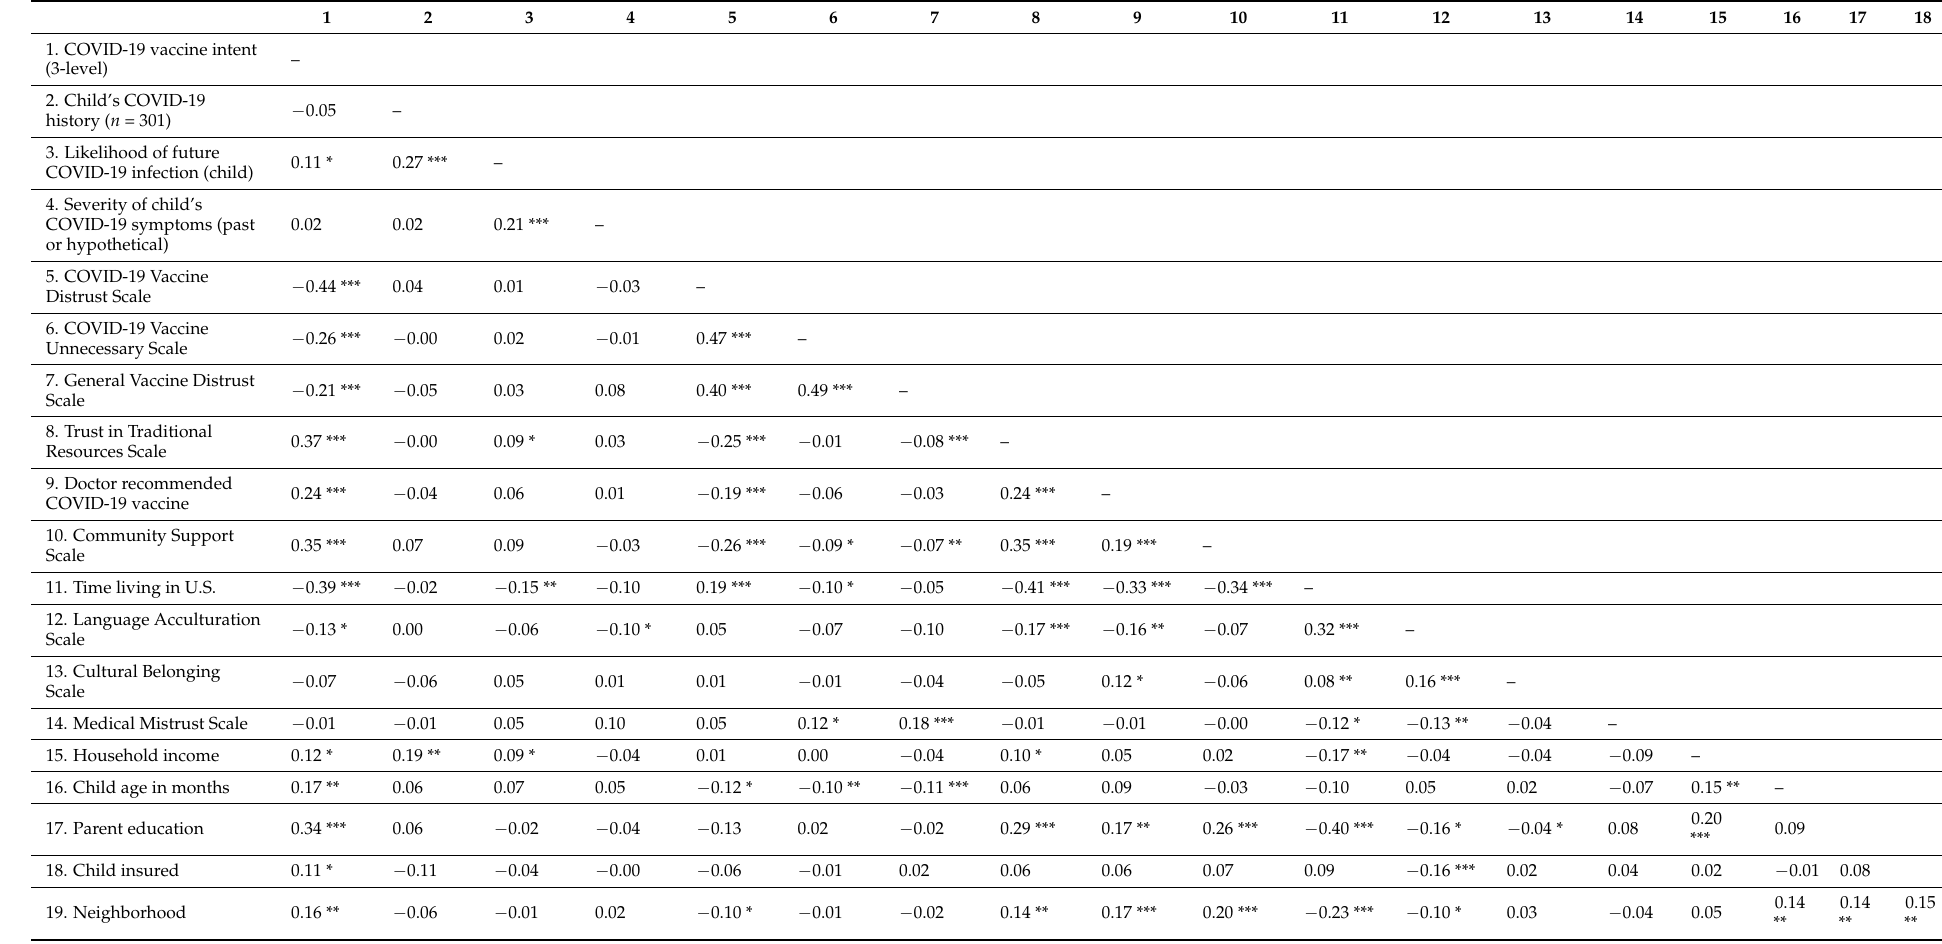
Table 3. Kendall’s tau-b correlations among the three levels of COVID-19 vaccine intent, health beliefs, demographic, structural and cultural